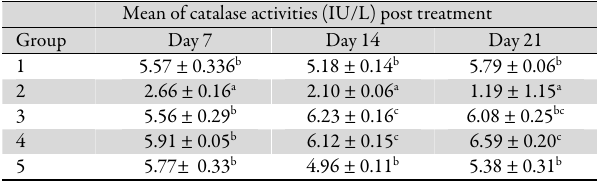
Different superscript along the same column (across groups) indicate significant difference at p <